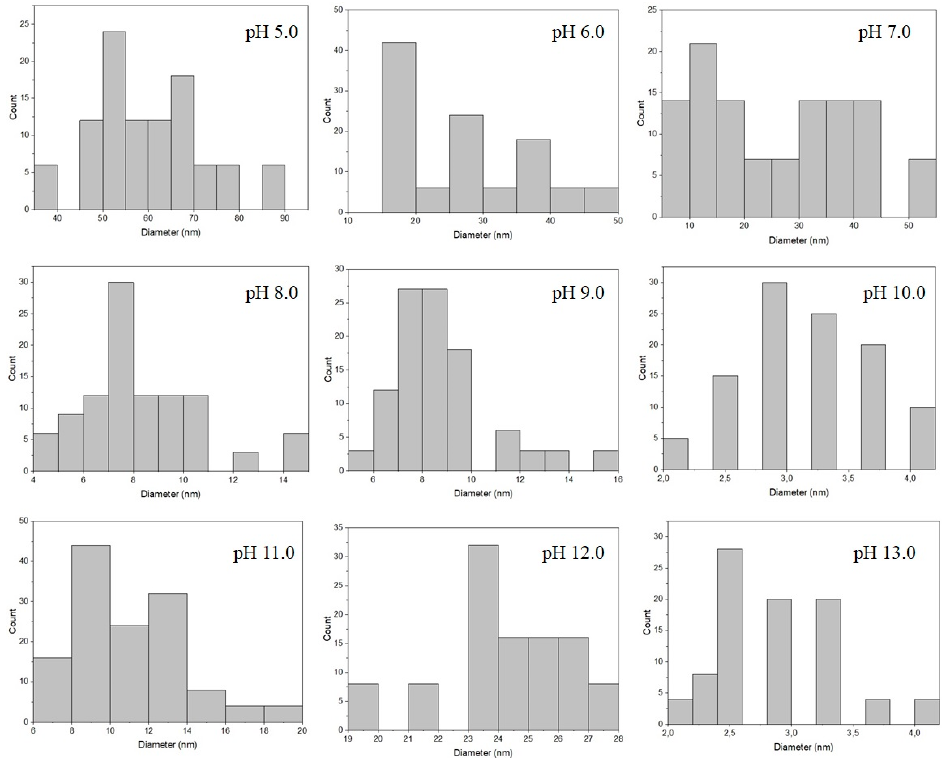
Figure 5. Histograms of AgNPs synthesized at pH range 5.0–13.0. The solution of pH 13.0 did not show a maximum absorption ( λ max ) around 400 nm, indicating that there were no AgNPs. Despite this, the TEM image shows the presence of some clustered AgNPs. As this solution showed the precipitation of a dark grey solid at the time of synthesis, it was not diluted for further testing and, thus, the actual amount of AgNPs was lower than that observed in the other solutions, which were diluted. The spectra of the more acidic solutions, with pH < 5.0, showed lower intensity. Biao et al. (2017) [48] observed that the pH of the medium directly influences the size and shape of AgNPs, and AgNPs synthesized at pH 4.0 are relatively larger than those synthesized at pH 5.0. Furthermore, AgNPs synthesized at pH 4.0 present a triangular shape, while those synthesized at pH 5.0 are spherical. In the TEM images, it can be seen that the AgNPs synthesized at pH 2.0 and 3.0 did not have a specific shape, while the AgNPs synthesized at pH 4.0 and 5.0 had well-defined contours but were agglomerated. For these reasons, it was not possible to obtain a histogram of the AgNPs synthesized at pHs 2.0, 3.0 and 4.0. Fu et al. (2021) [9] observed that the absorbance of AgNPs decreased in acidic solutions and increased in alkaline solutions, since AgNPs are more stable in an alkaline environ- ment. Zhao et al. (2022) [49] observed that a high pH tends to result in a high reduction rate of silver ions and a high formation rate of AgNPs. The UV-Vis spectra of solutions with pH between 6.0 and 11.0 showed similar be- havior, exhibiting a relatively intense absorbance, with λ max around 390 nm, which may indicate spherical [50] or small [51] AgNPs. Comparing the UV-Vis spectra of AgNPs (Fig- ure 3) with those simulated by Bertin and Perottoni (2020) [52], using the Mie model for spherical particles, it can be assumed that the synthesized AgNPs had a particle size be- tween 5 and 20 nm. The width of the bands also indicated that the particle size distribution was similar for all samples tested [53]. TEM images confirmed the spherical shape of these AgNPs, but it was observed that the pH still influenced the size and dispersion of AgNPs. According to Dong et al. (2009) [54], the pH of the solution can affect the size and shape of AgNPs, since the reducing activity of sodium citrate is pH-dependent. From pH 7.0,